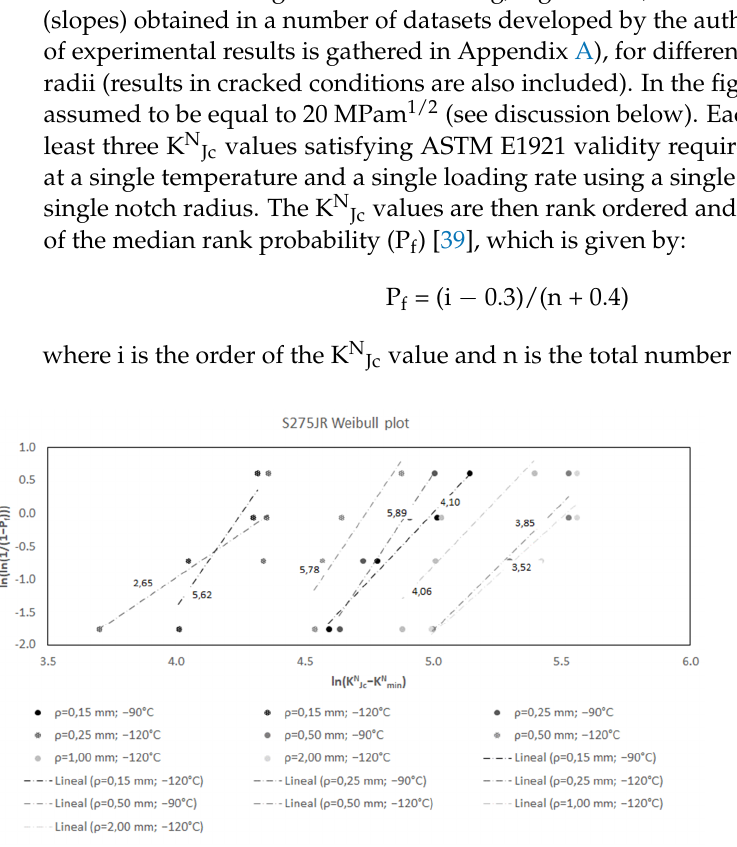
Figure 1. Statistical distribution of K NJc values determined from the three-parameter Weibull function for steel S275JR.